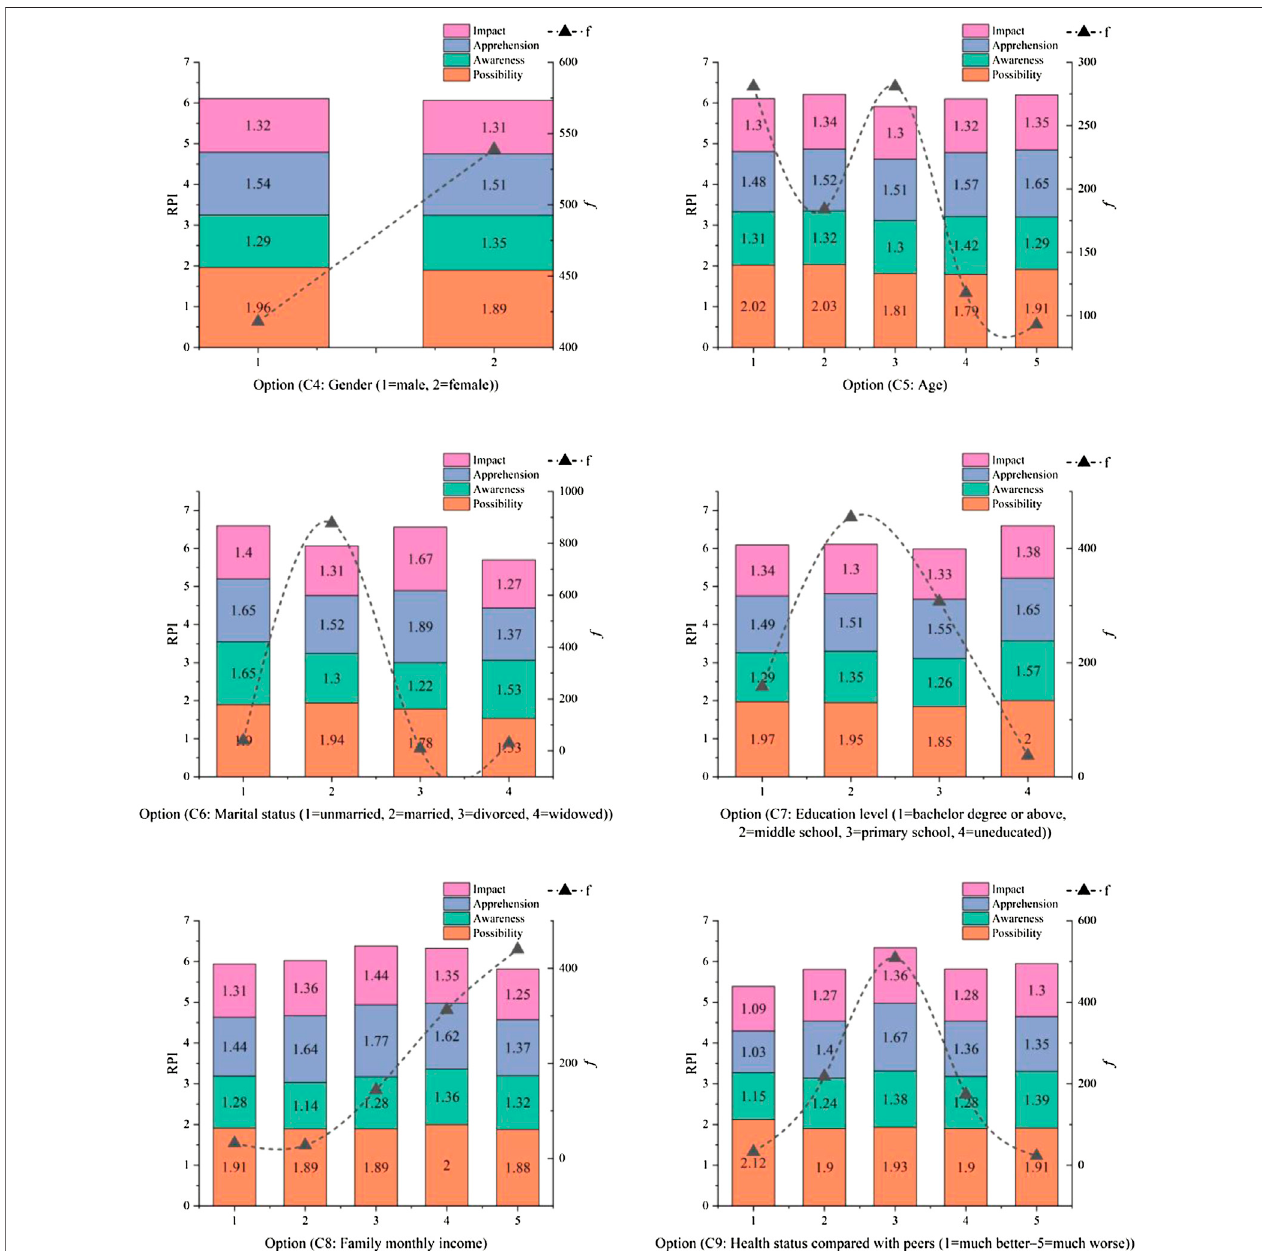
FIGURE 6 | The impact of individual characteristics on risk